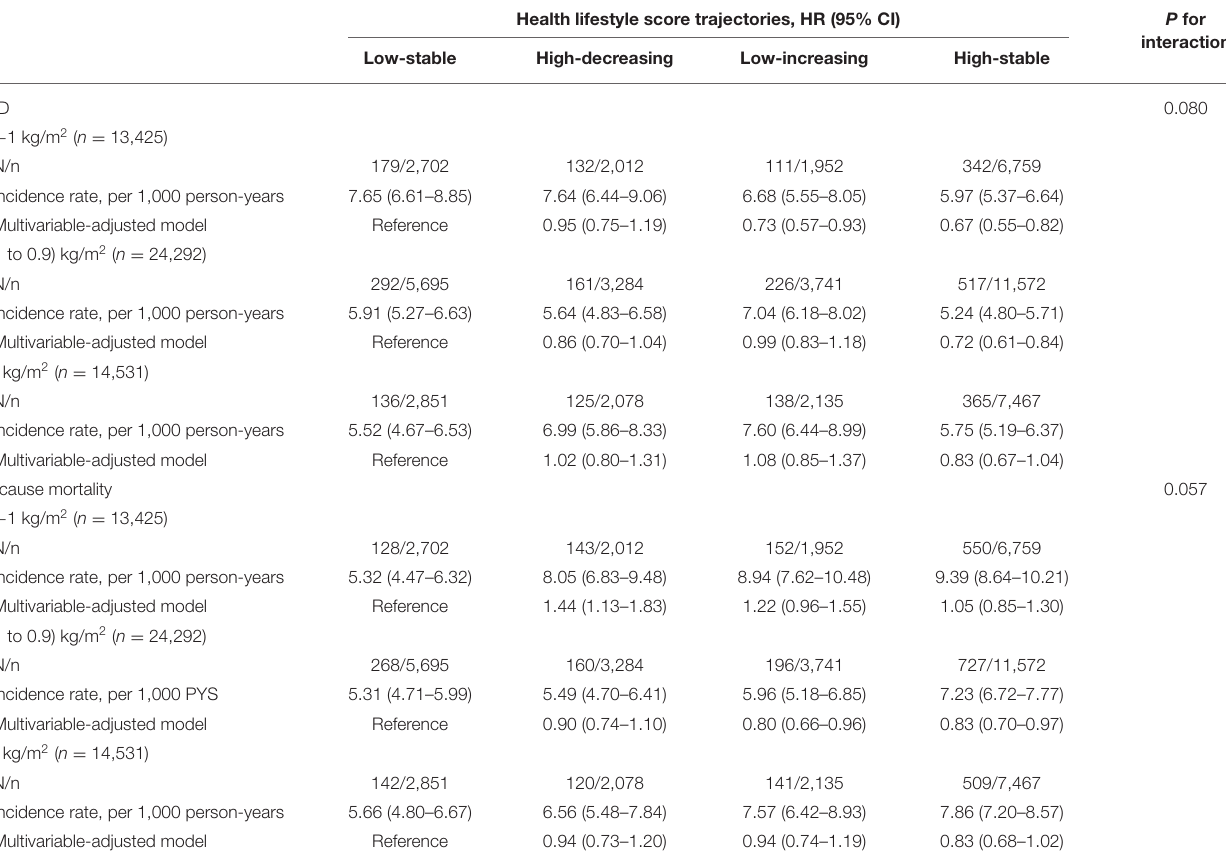
TABLE 5 | Stratified analysis of CVD and all-cause mortality according to BMI change from 2006 to